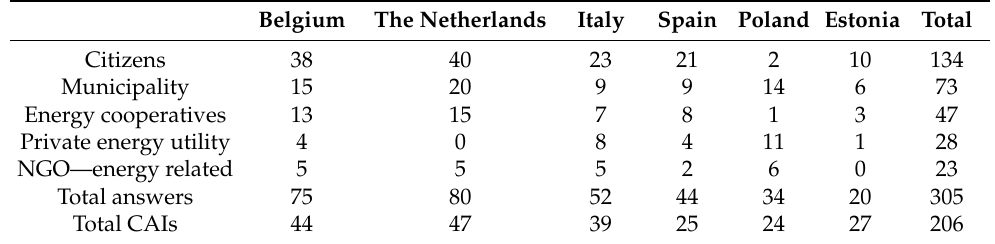
Table 2. The main actors at the origin of CAIs.